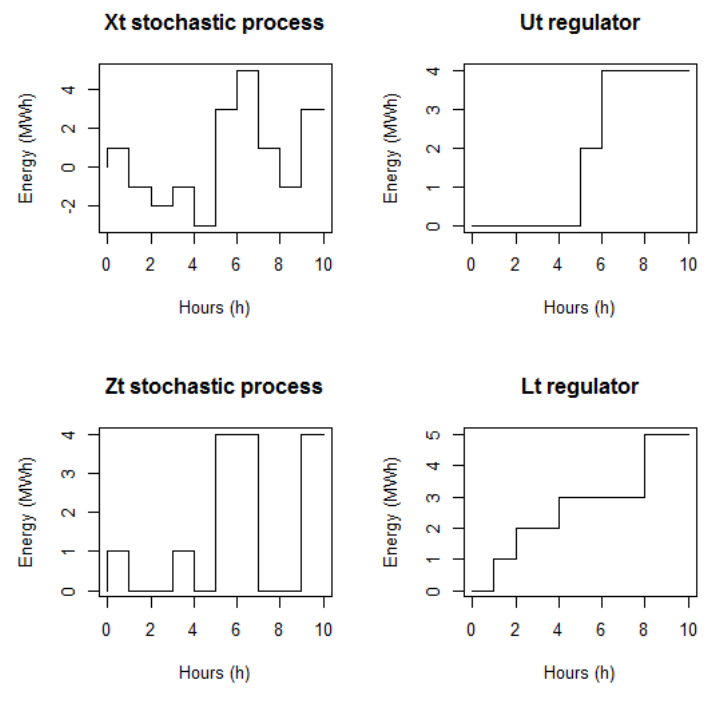
Figure 2. The two ‐ sided regulator with B = 4 MWh. Figure 2. The two-sided regulator with B = 4